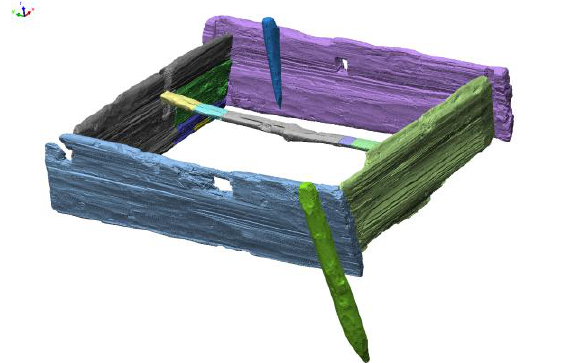
Figure 2. Visualisation of the timbering properties by the virtual reconstruction of the wooden object